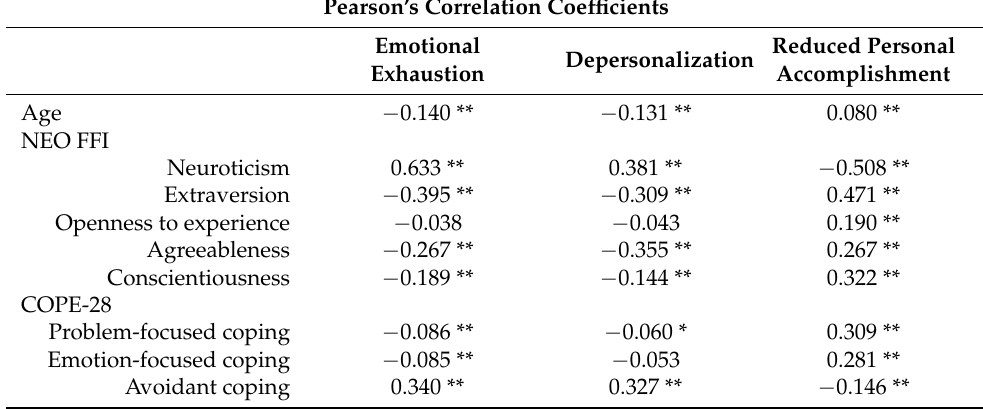
Table 5. Pearson correlation coefficients between the scores in each of the three dimensions of MBI-HSS and the remaining variables analyzed.